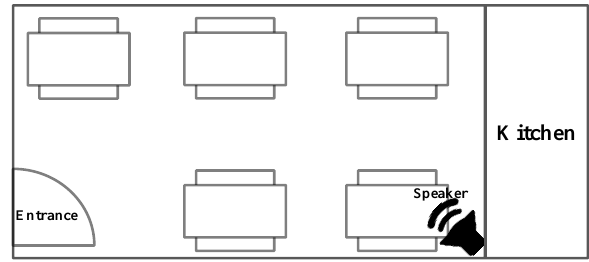
Fig. 5. The floor plan of a small restaurant for the sequence assignment experiment